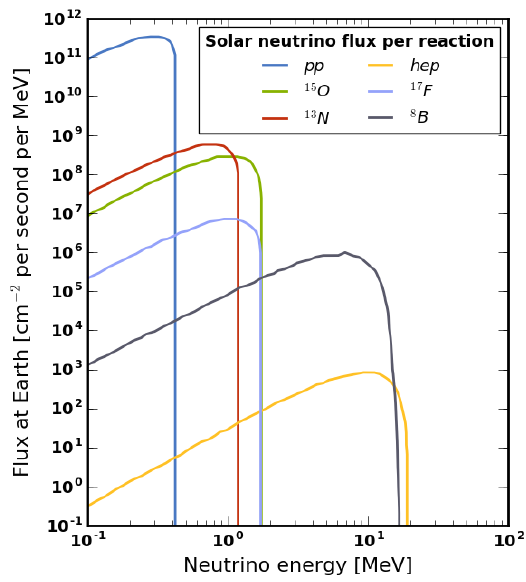
Figure 23: A few components of the solar neutrino flux